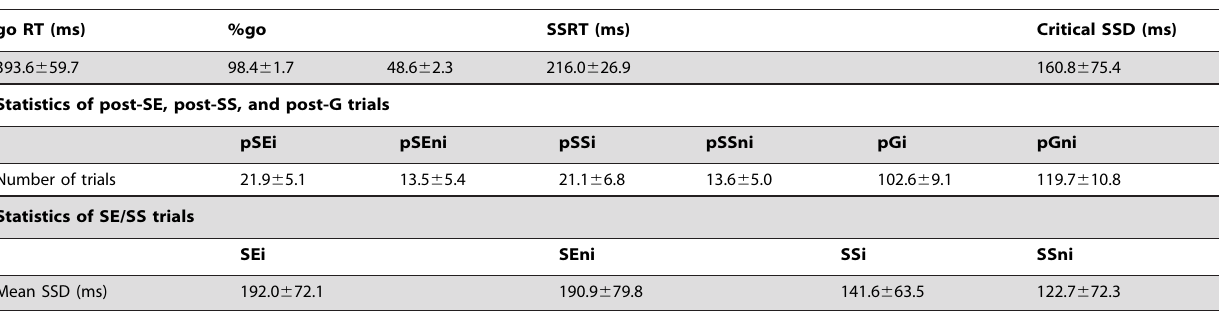
Table 1. General Behavioral